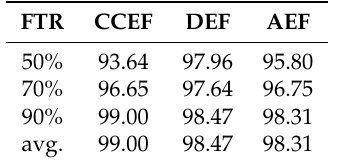
Figure 8. Detection capacity (FTR 50, 70, and 90% at FCO). Table 4. Detection capacity comparison (%